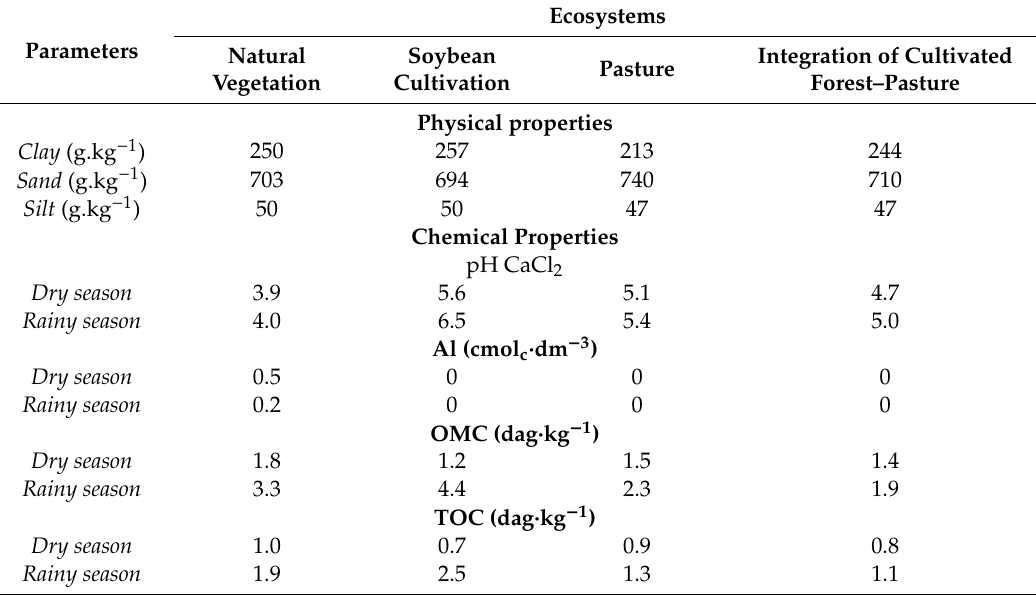
Table 1. Physicochemical properties of soil samples (each composed of 20 subsamples) collected at four ecosystems in Sucupira, Tocantins, Brazil. Samples in January 2015 (rainy season) and July 2016 (dry season). Analyses conducted by Sellar An á lises Agr í colas, Gurupi, Tocantins state. OMC: organic matter content; TOC: total organic